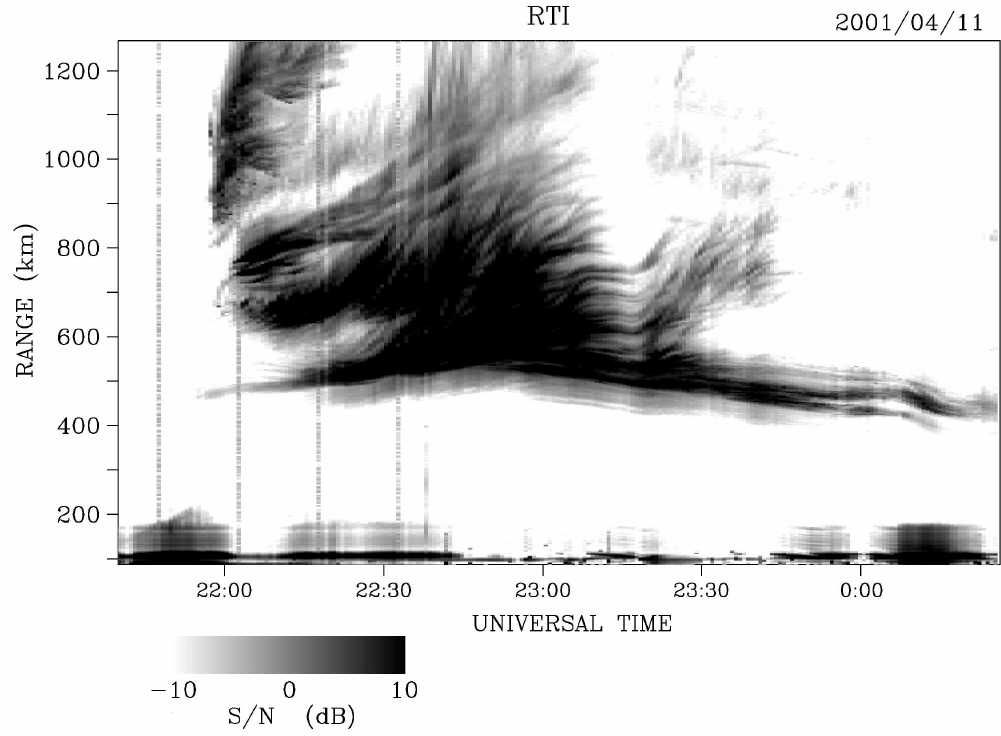
Fig. 3a. VHF radar RTI (Range-Time-Intensity) plot of the echoes from the ionospheric irregularities for the storm night of 11–12 April 2001.